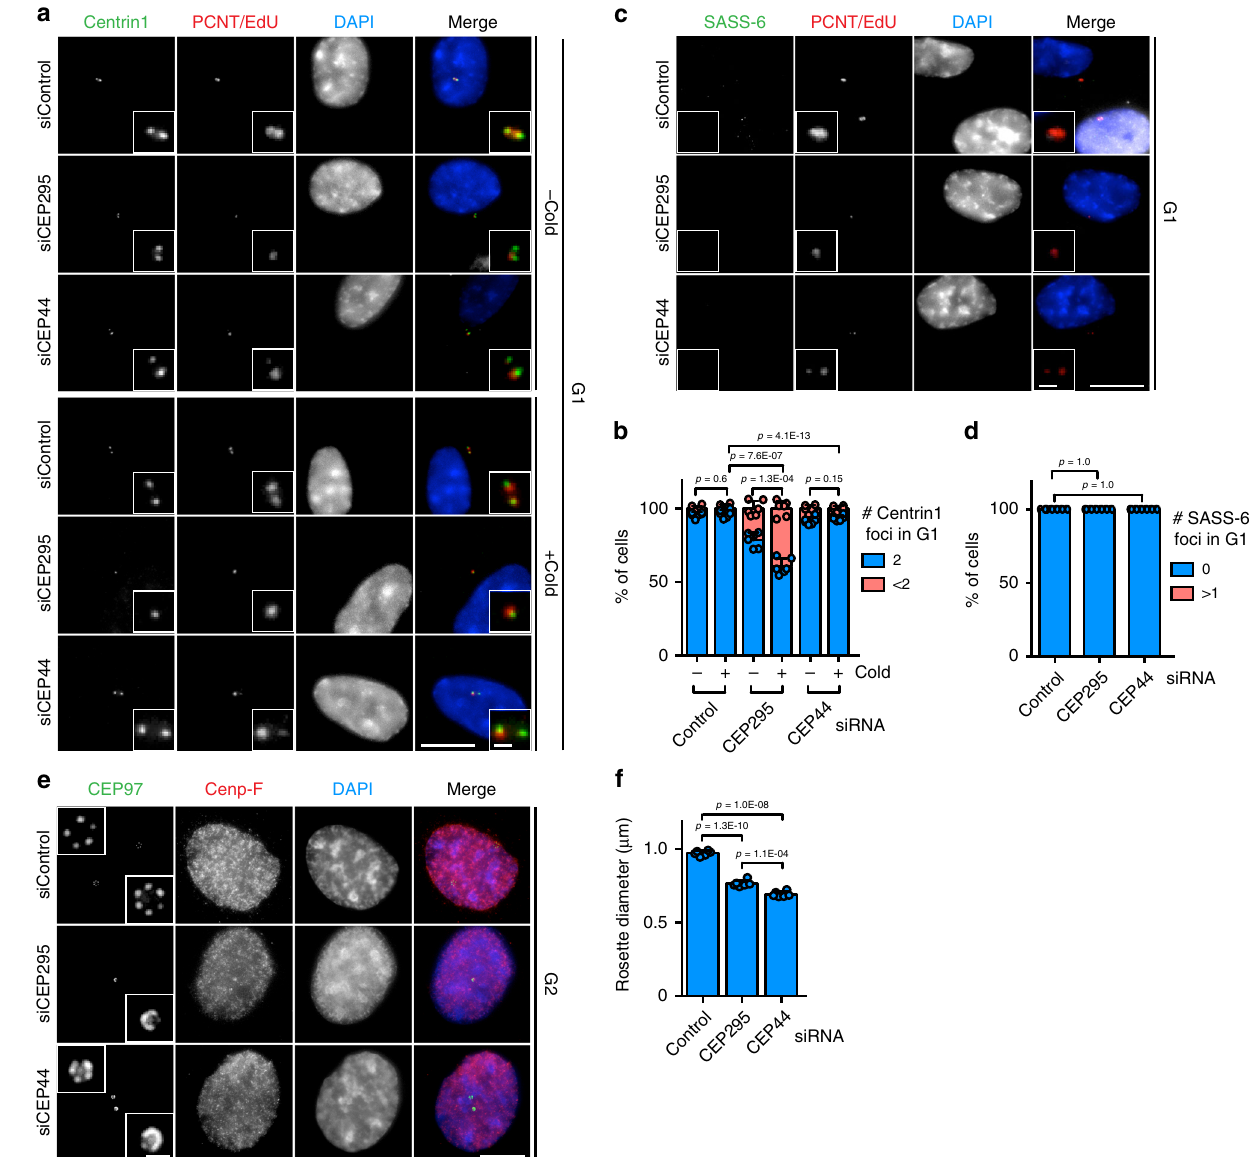
Fig. 5 CEP295 stabilises new dCs. a IF of siControl, siCEP295 and siCEP44 depletion samples untreated (upper 3 panels) and treated with cold (upper 3 panels). Similarly to control cells, in both cold treated and untreated siCEP44 samples G1 cells contained 2 centrioles (judged by centrin1 signals).